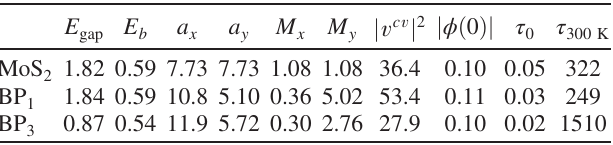
TABLE I. Exciton parameters for unstrained MoS 2 monolayers and BP mono- and trilayers, measured in electronvolts, Angstroms, electron masses, and picoseconds. Here, j v cv j 2 stands P for j v cv j 2 . See Ref. [27] regarding the value of E gap and E ex for i i MoS 2